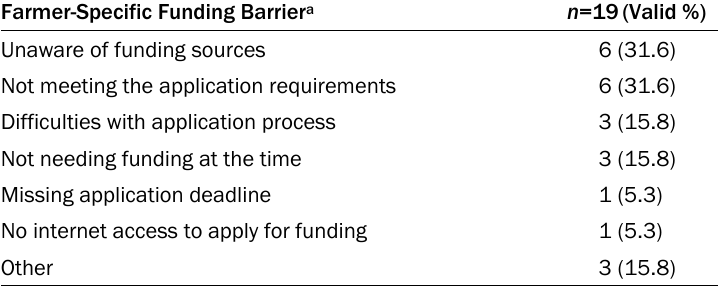
Table 3. Barriers to Utilization of and/or Access to Farmer-